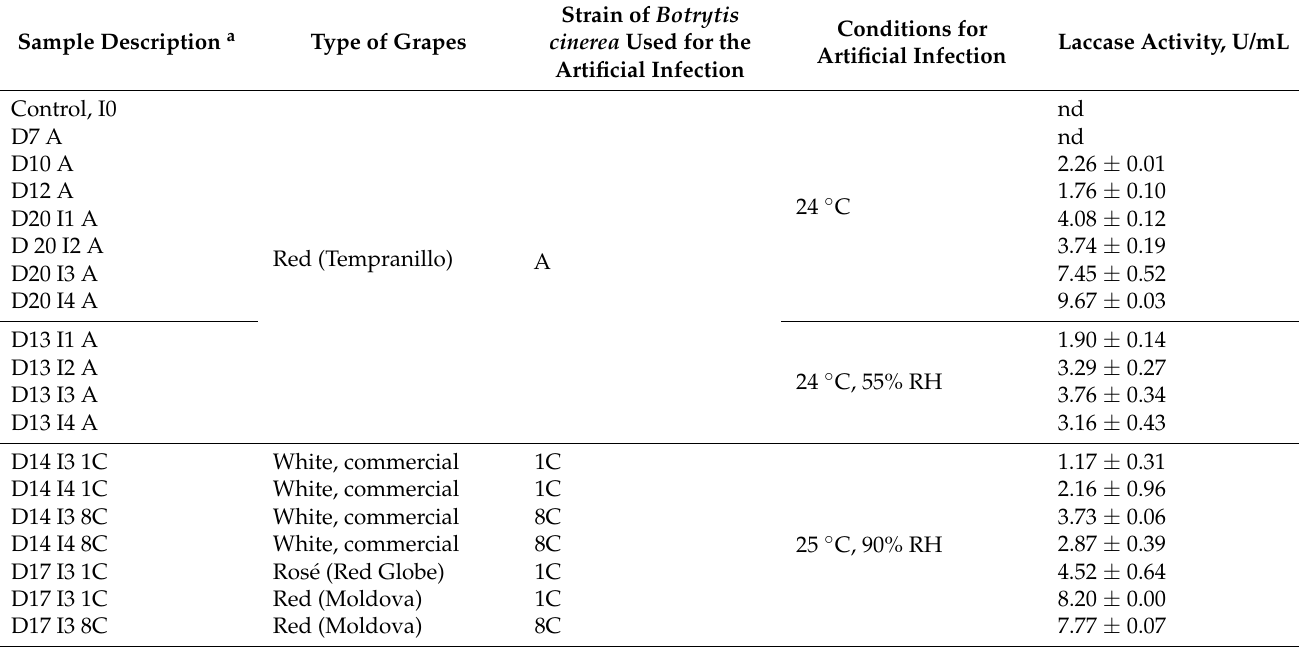
Table 2. Evaluation of the laccase activity of artificially infected grapes by the electrochemical